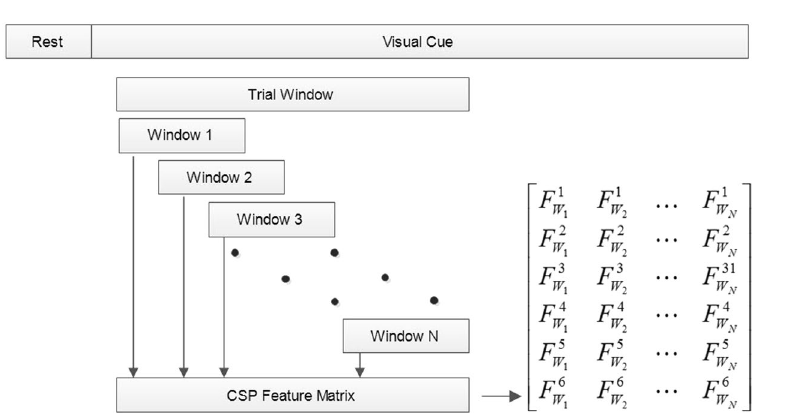
Figure 2. Performing segmentation and obtaining the feature